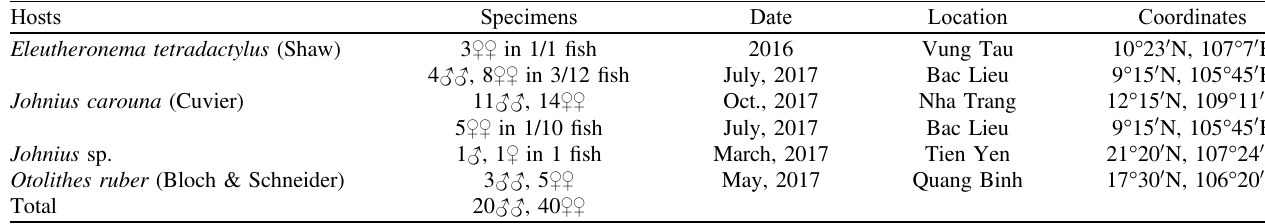
Otolithes ruber (Bloch &